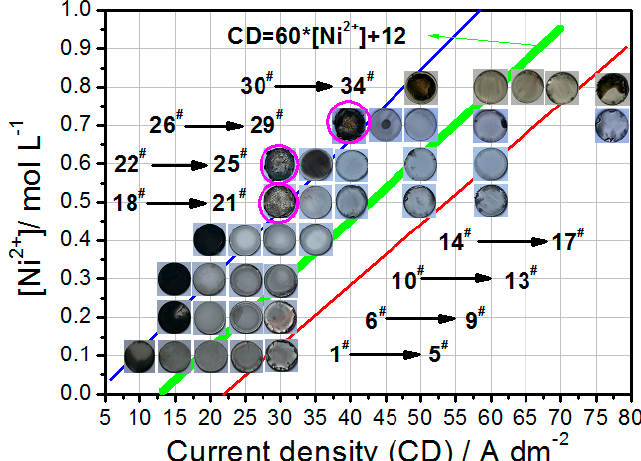
Figure 2. The photographs of Fe–Ni alloys electrodeposited from chloride baths with different current densities and concentrations of Ni 2+ ions. The samples are marked 1 # to 34 # , respectively. Because the samples circled in Figure 2 are almost completely exfoliated, they are not numbered.